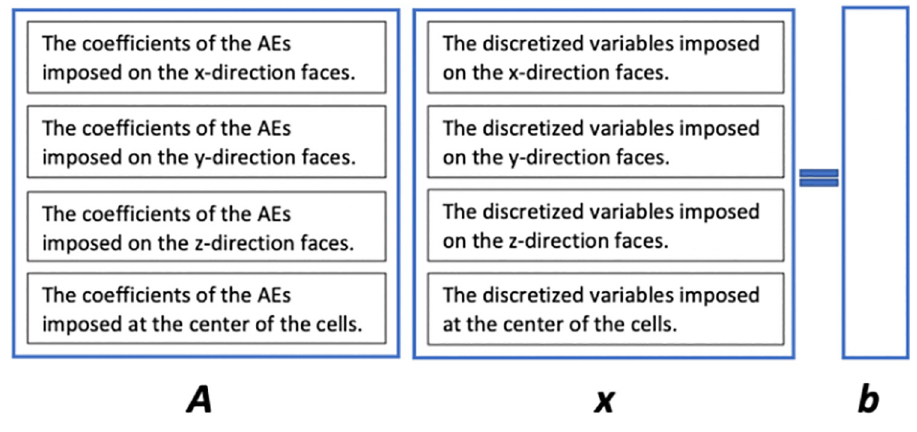
Fig 4. The linear system Ax = b , where A stands for the coefficient matrix, x stands for the unknown vector, and b stands for the right-hand-side vector.